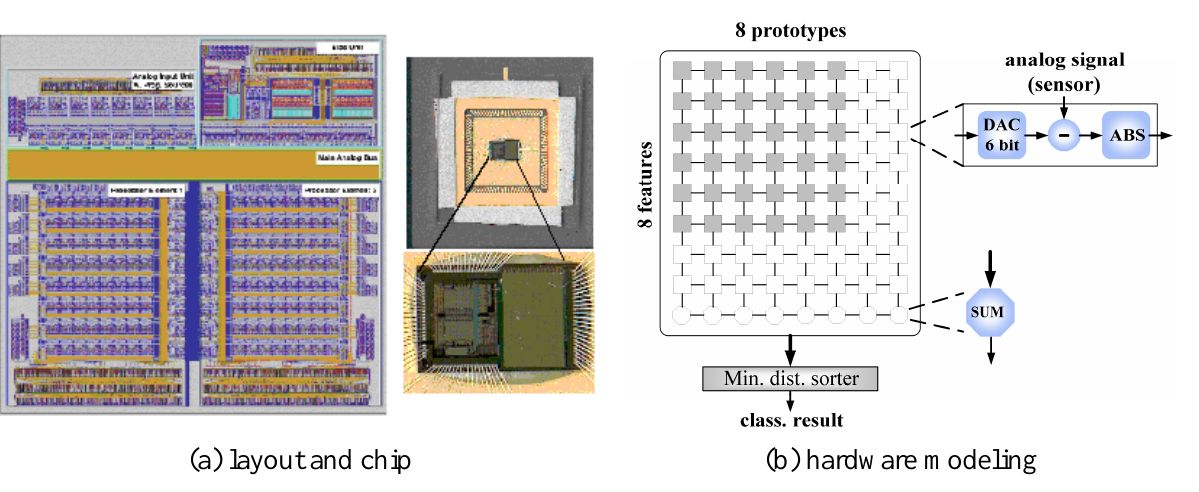
Figure 25. Layout and chip of reconfigurable mixed-signal classifier chip and hardware modeling of nearest neighbor